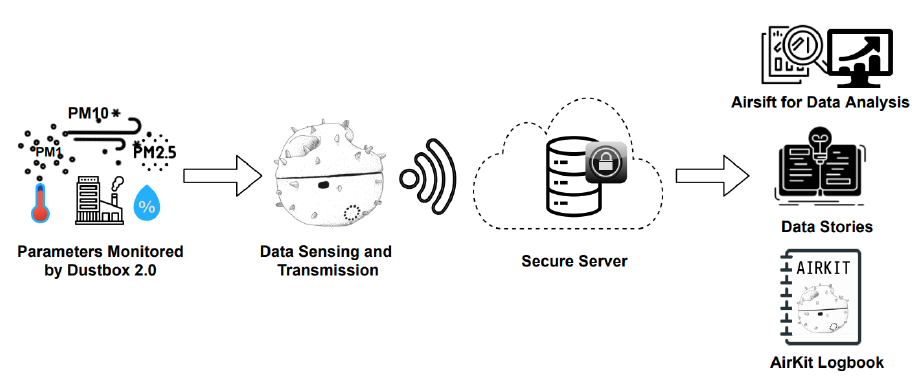
Figure 1. Overview of AirKit